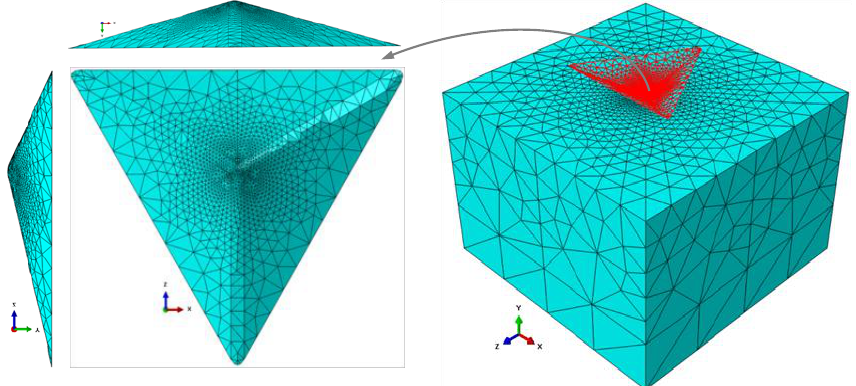
Figure 2. Schematic 3D view of the model configuration and mesh pattern of the sample and indenter in the nanoindentation experiment.